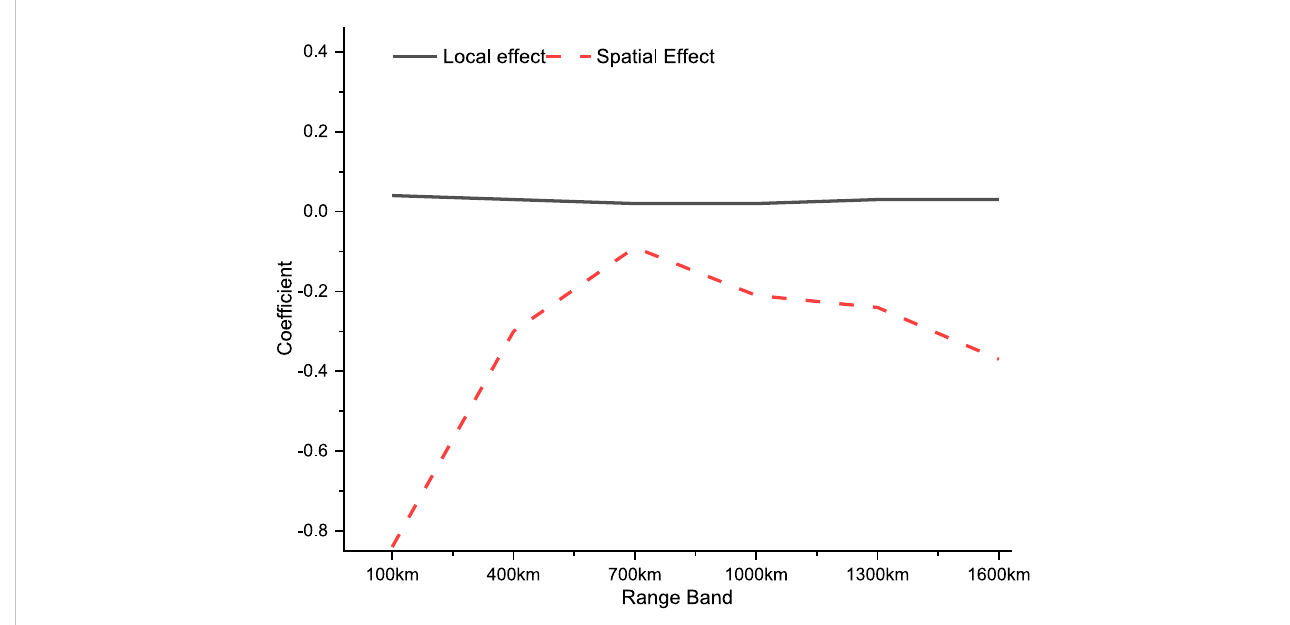
FIGURE 4 The local-neighborhood effects of the digital economy ’ s impact on rural revitalization under different spatial